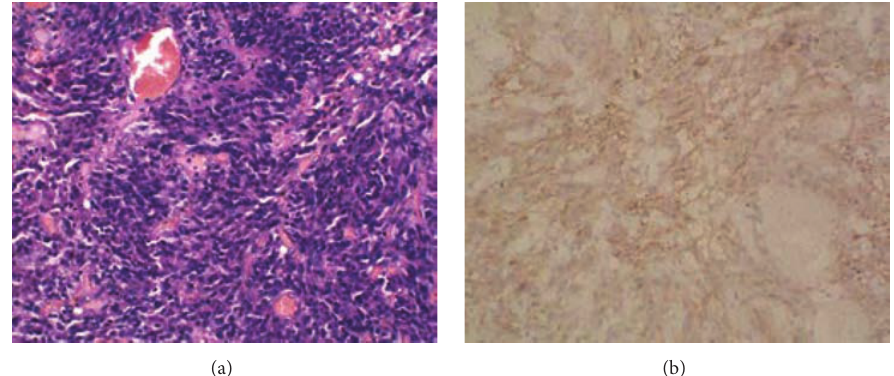
Figure 3: Histopathological manifestations of meningioma with cerebriform pattern. Hematoxylin-eosin staining ( × 100) revealed a large number of spindle cells rich in Vascellum , without distinct karyokinesis (a). Immunohistochemical staining (diaminobenzidine × 20) showed cells positive for epithelial membrane antigen